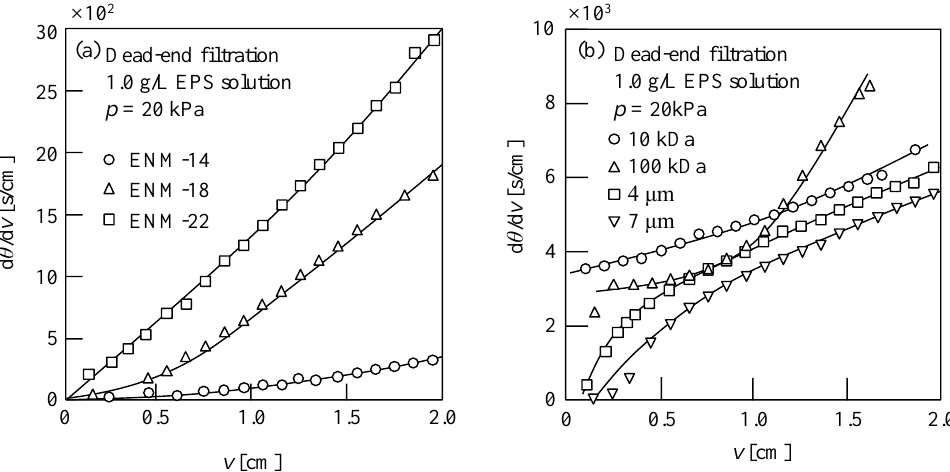
Figure 5. Filtration behaviors during the dead-end filtration of a 1.0 g/L EPS solution at a filtration pressure ( p ) of 20 kPa for ( a ) the ENMs, and ( b ) the commercial membranes. The horizontal axis ( v ) represents the cumulative filtrate volume per unit membrane area, the vertical axis (d θ /d v ) represents the reciprocal of the filtration rate, and θ is the filtration time.